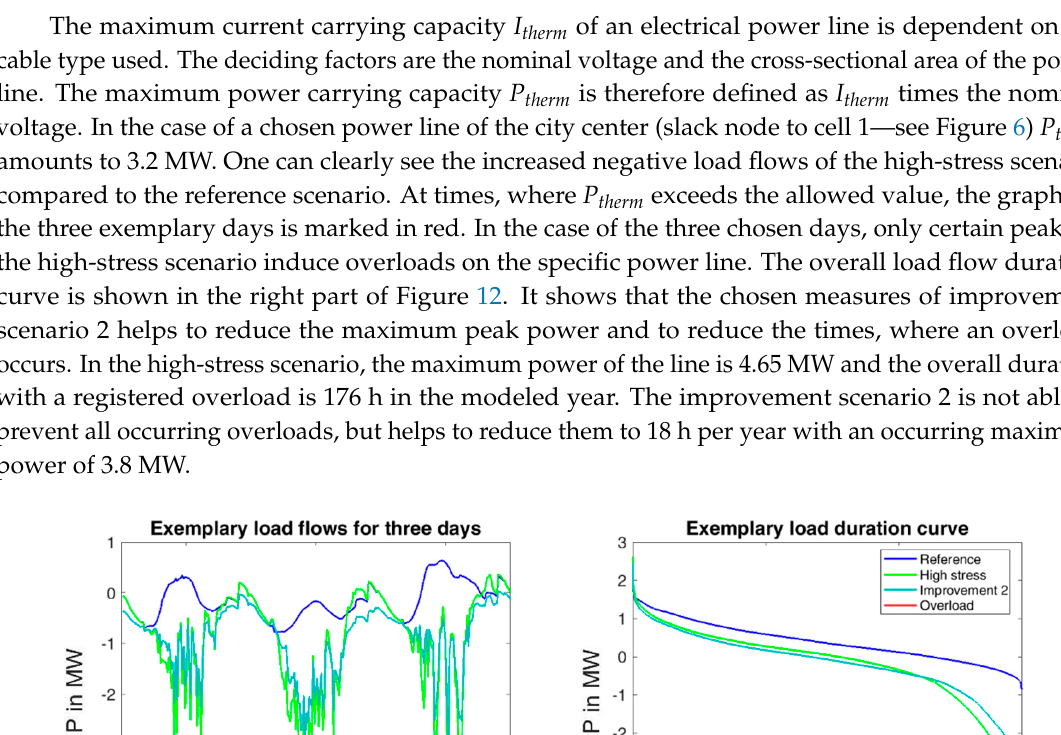
Figure 11. Exemplary load flows for a selected week on the power line between cell 5 and cell 18 (electricity, natural gas, heat) and the corresponding annual load duration curve.